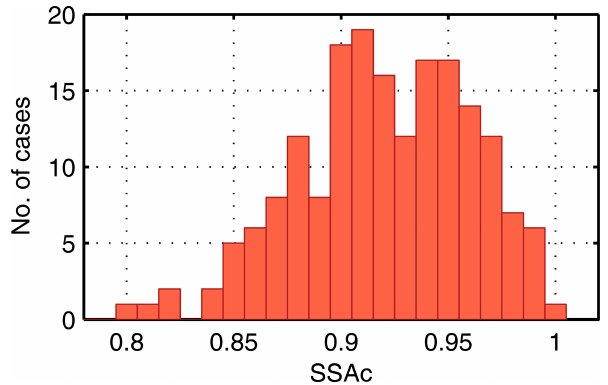
Figure 7. Distribution of SSAc retrieved from diffuse DSR for cirrus–cirrostratus cases in Payerne. The mean SSAc value is 0 . 92 ± 0 . 04.